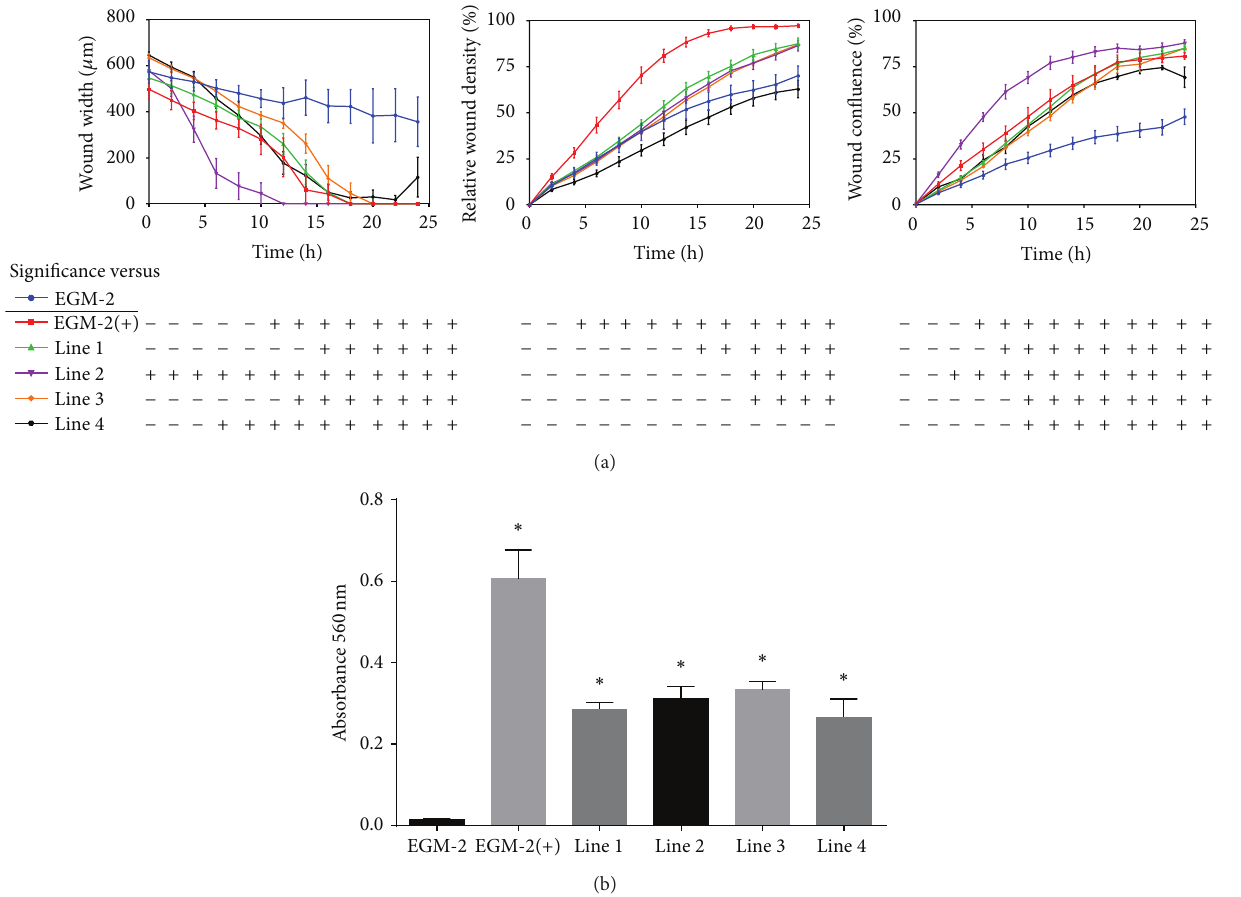
Figure 7: Conditioned media from hypoxic neonatal sbMSCs promote HUVEC migration and proliferation. (a) HUVEC migration was assessed by a scratch assay. Conditioned media from all hypoxic sbMSCs lines enhanced and accelerated scratch healing as assessed by average (error bars = standard deviation) wound width, density, and confluence as compared to basal media, EGM-2. Growth factor supplemented EGM-2(+) was used as a positive control. Data were analyzed by one-way ANOVA with post hoc Tukey test and are representative of two independent experiments. (b) HUVEC proliferation was assessed by the MTT assay. Conditioned media from all hypoxic sbMSCs lines enhanced HUVECs proliferation as compared to basal EGM-2 ( ∗ , 𝑝 < 0.05 ). Data were analyzed by one-way ANOVA with post hoc Tukey test and are representative of two independent